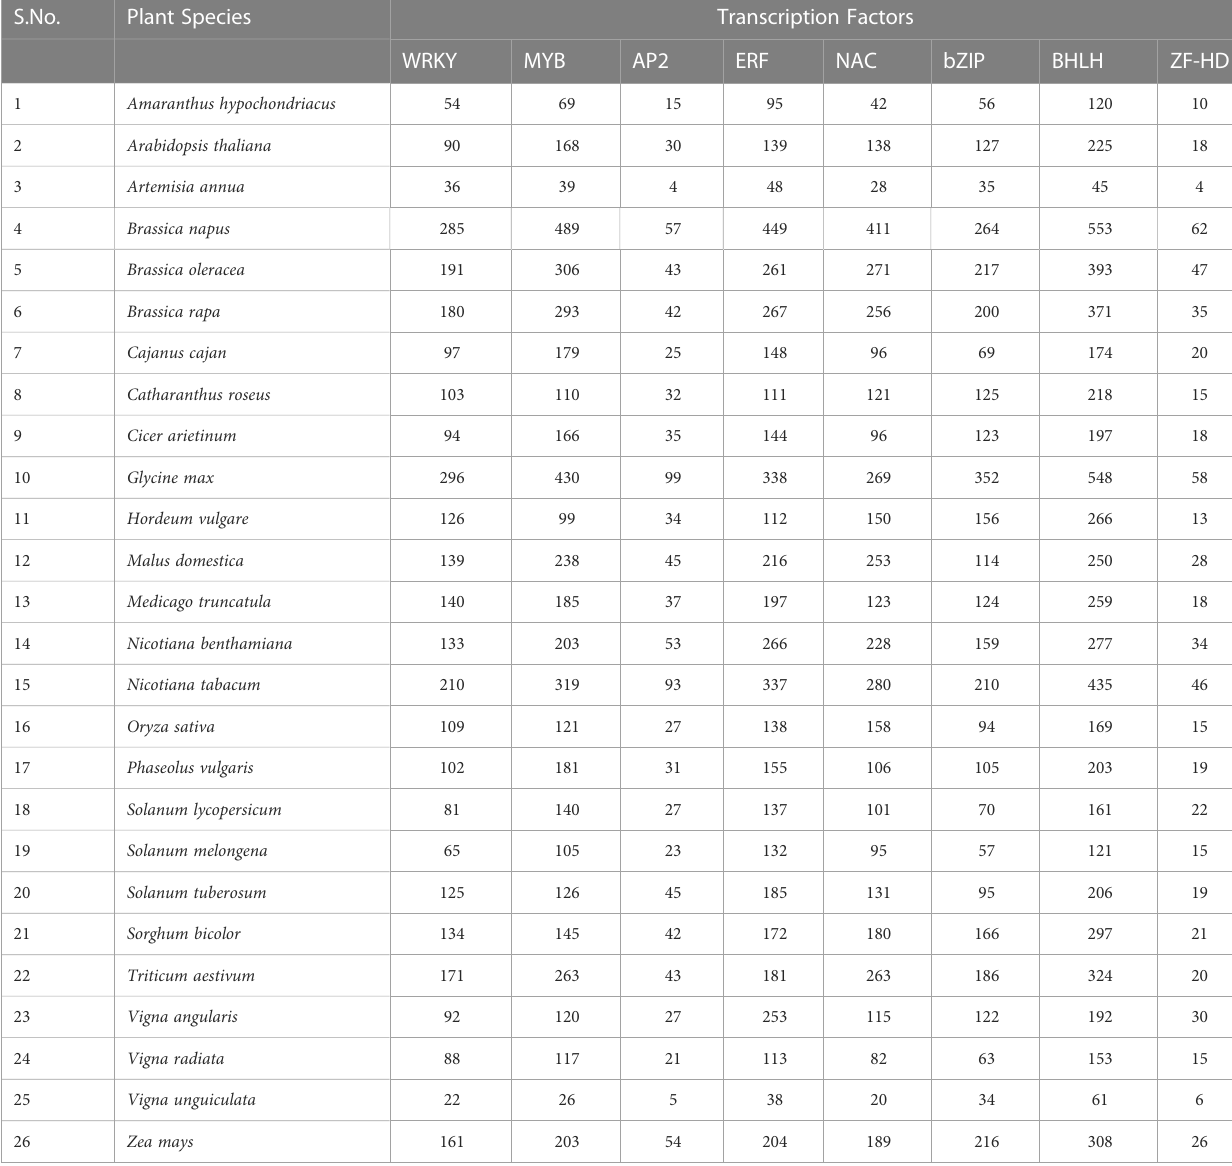
TABLE 1 Number of Genes encoding for Transcription factors involved in plant defense (Summarized from Transcription Factor Database, 2022).